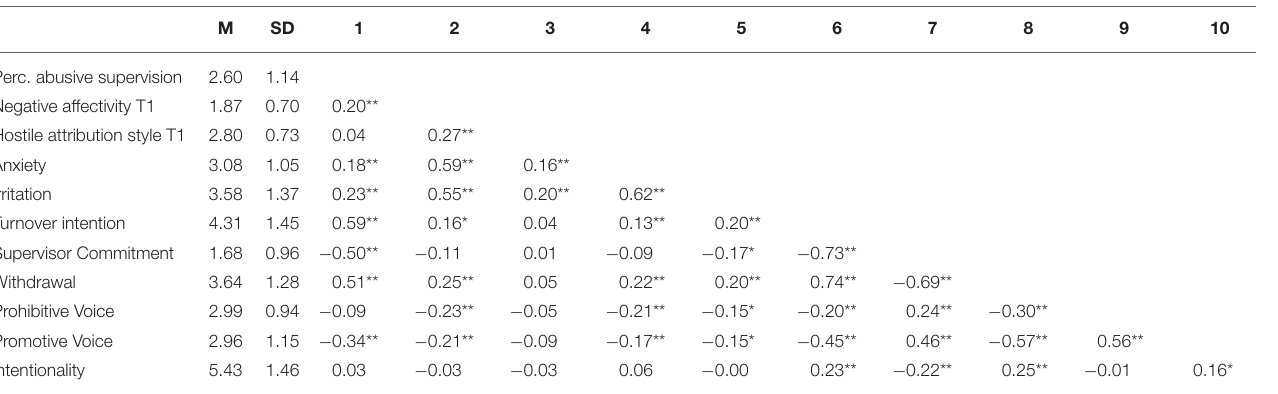
TABLE 5 | Means, standard deviations and, intercorrelations (Study